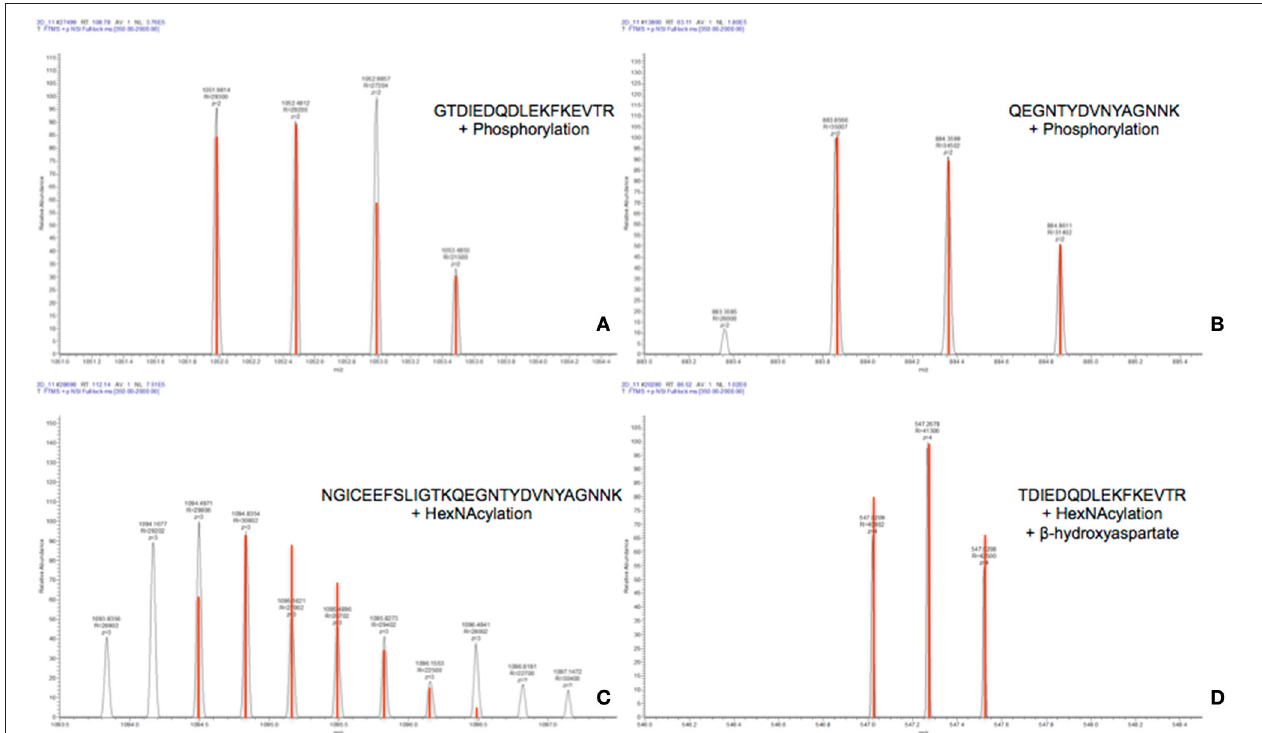
FIGURE 6 | MS spectra of modified peptides and their theoretical isotopic distribution (in red). (A) Spectrum n ◦ 27502. (B) Spectrum n ◦ 13801. (C) Spectrum n ◦ 28697. (D) Spectrum n ◦ 20288.